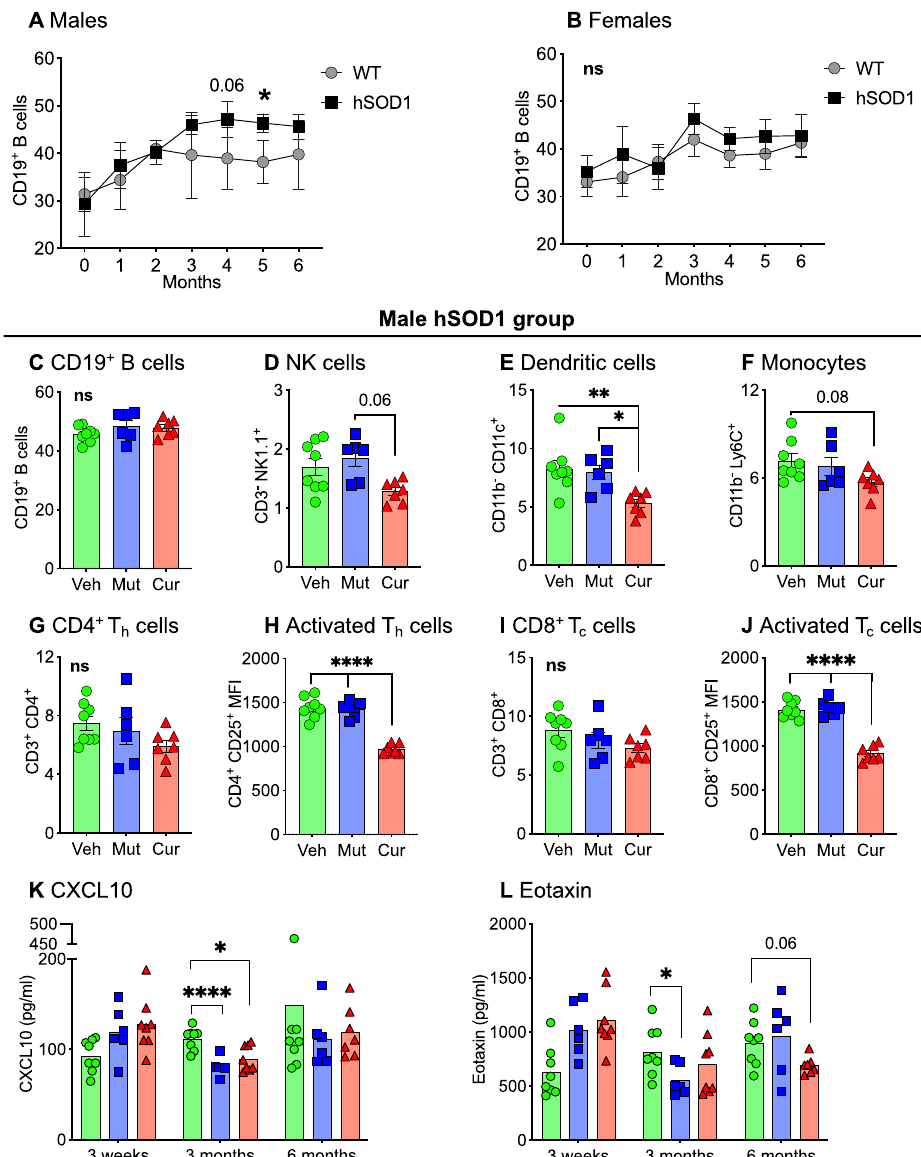
Figure 6. Peripheral blood immune responses. ( A ) Immunophenotyping of peripheral blood demonstrated significantly increased CD19 + B cells in hSOD1 males compared to WT controls, month 4 onwards, This phenomenon was not observed in female mice ( B ), mixed-effects model analyses (REML). ( C – J ) Within the male hSOD1 cohort, curli-fed mice exhibited significantly decreased markers of NK cells, dendritic cells, monocytes, activated T h cells and activated T C cells. ( K , L ) Pro-inflammatory cytokines CXCL10 (3 months) and eotaxin (6 months, trending) were decreased in both bacterial-fed male hSOD1 mice compared to vehicle groups. ns = not significant, * p < 0.05, ** p < 0.01, **** p < 0.001, one- or two-way ANOVA, n = 6–8 per